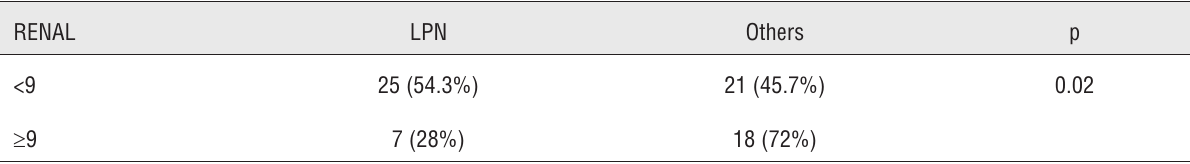
Table 3 - conversion rate according to REnAL ≥ 9.